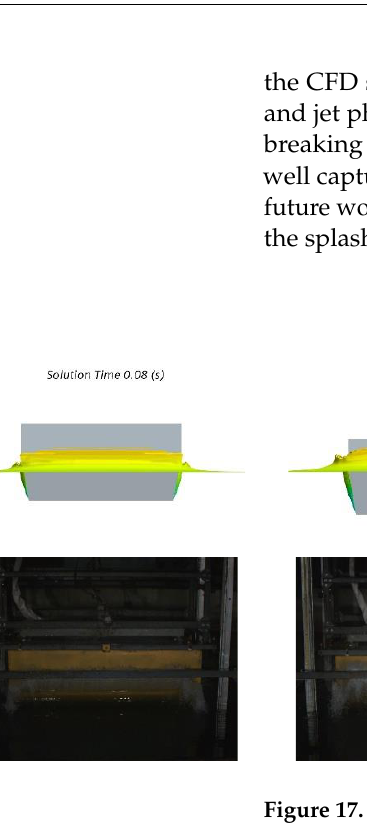
Figure 16. Visualization of FSI results during water entry procedure (Case 4): ( a ) volume fraction of fluid domain; ( b ) free surface around the wedge; ( c ) structural stress distribution on the wedge.